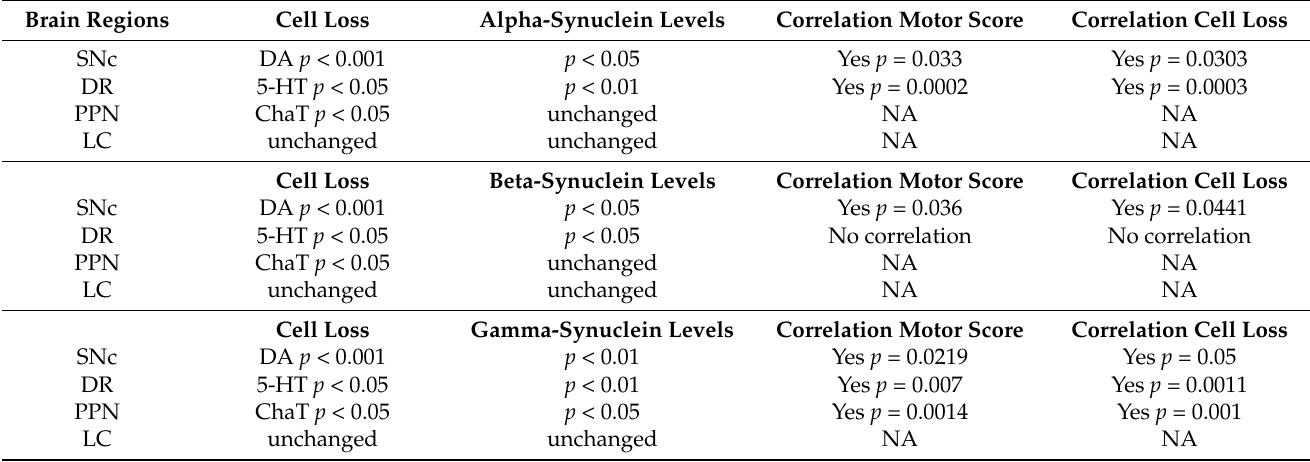
Table 2. Table 2 summarizes the main results obtained in the different regions of interest for the cell loss analysis, the levels of the different synucleins, and the correlation analysis in the MPTP- intoxicated monkeys compared to the control group. Abbreviations: SNc, substantia nigra pars com- pacta; DR, dorsal raphe; PPN, pedunculopontine nucleus; LC, locus coeruleus; NA, not applicable. Brain Regions Cell Loss Alpha-Synuclein Levels Correlation Motor Score Correlation Cell Loss